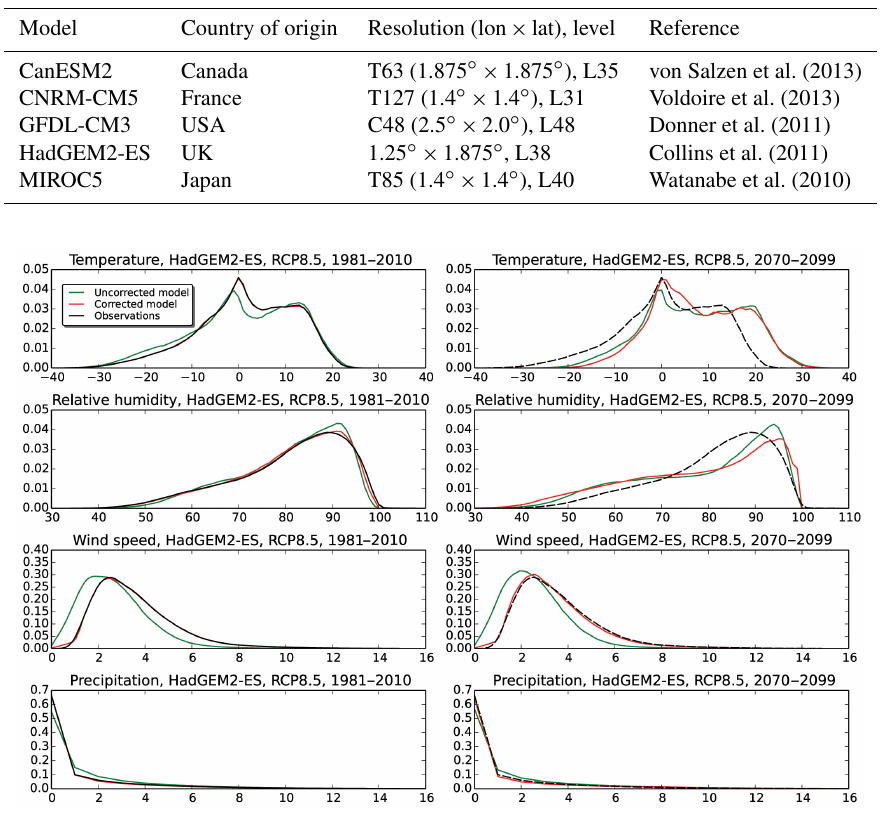
Figure 1. Probability distributions of daily mean 2m air temperature ( ◦ C), daily mean 2m relative humidity (%), daily mean 10m wind speed (ms − 1 ) and daily total precipitation (mm) in the HadGEM2-ES model for the periods 1981–2010 and 2070–2099 under the RCP8.5 scenario over the whole of Finland. Green curves represent the uncorrected model data and red curves the bias-corrected model data. Black curves represent the observational data during the calibration period 1981–2010. Dotted black curves display the observational probability distributions during the calibration period